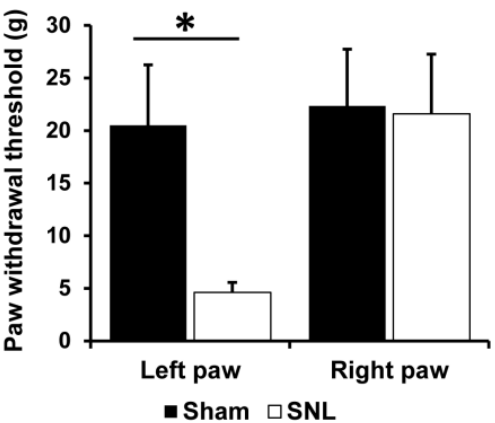
Figure 2. Behavior test for the assessment of mechanical allodynia one day before the FDG PET scan. Bilateral hind paw withdrawal thresholds (PWT) for von Frey filaments stimulation were assessed in the sham-operated (closed bar, n = 12) and SNL (open bar, n = 10) rats. The data are presented as mean ± standard deviation of the mean (SD). *, p < 0.05, two-tail unpaired t- tests.